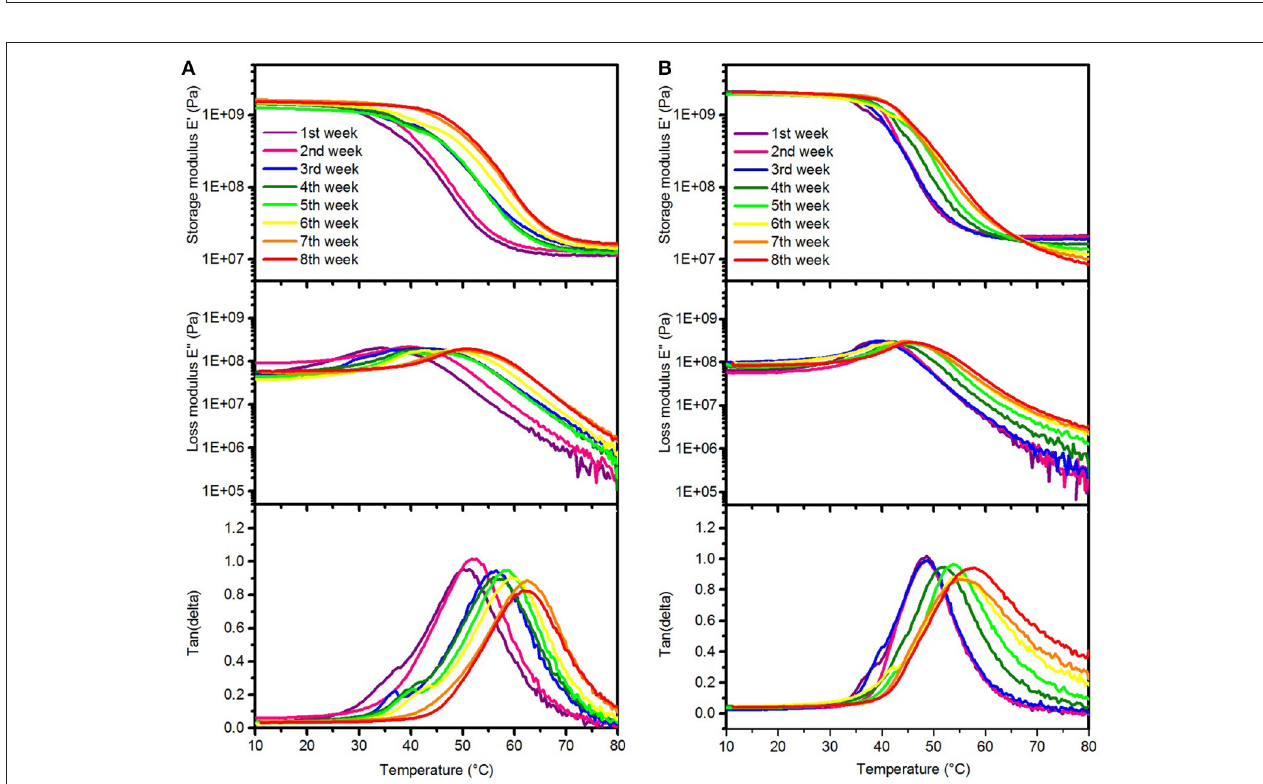
FIGURE 4 | Representative DMA measurements of SMP-A (A) and SMP-B (B) showing changes in the storage modulus (top), loss modulus (center), and tan delta (bottom) after various aging times in PBS at 75 ◦ C, respectively.